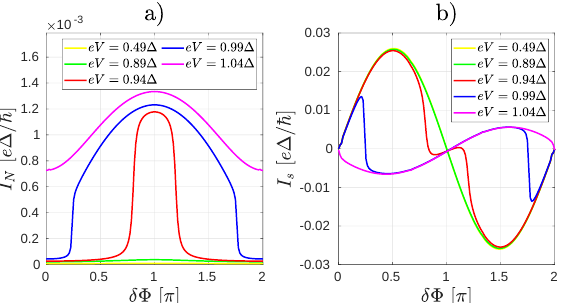
Figure 3. The currents I N ( a ) and I s ( b ) as a function of the phase difference δ Φ between the superconducting leads for the system depicted in Figure 2 for several bias voltage eV . ( a ) a robust peak in I N appears around the phase the difference π when the bias voltage is comparable to the superconducting gap ∆ . ( b ) the supercurrent shows a π transition for eV > ∆